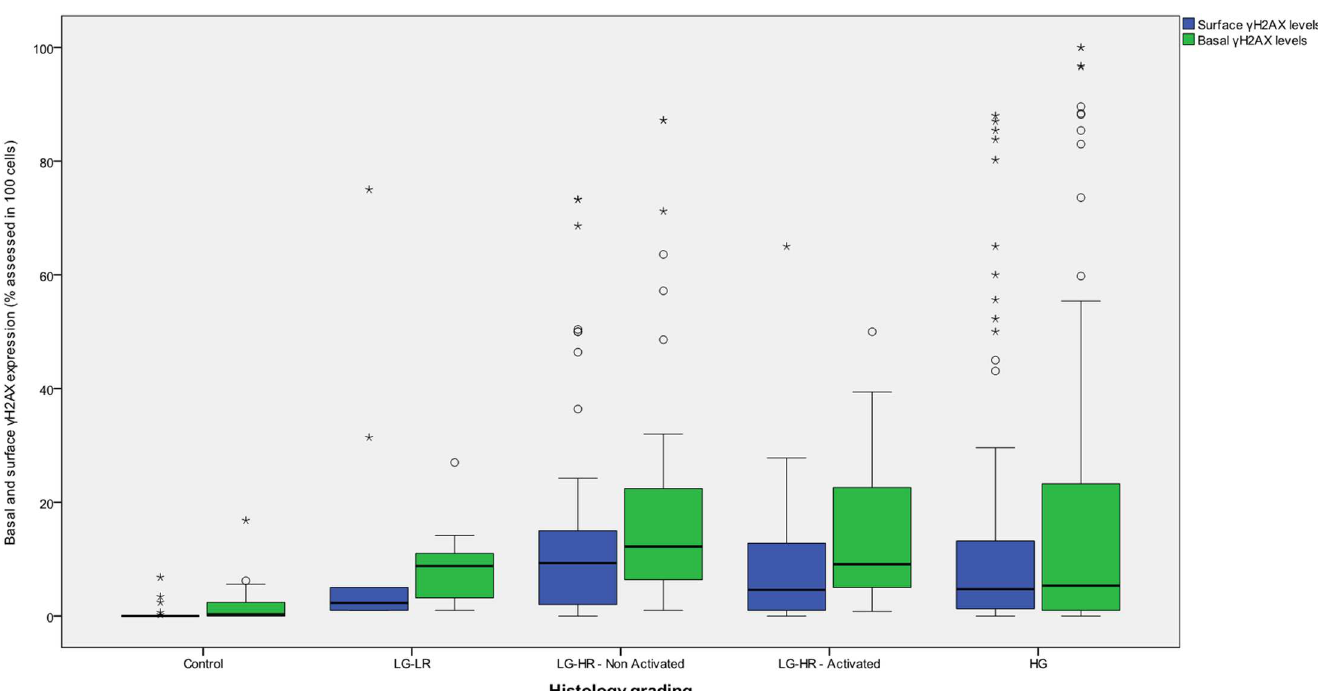
Fig 1. Basal and surface γ H2AXexpression (% positivity in 100 assessedcells) according to histological grade.